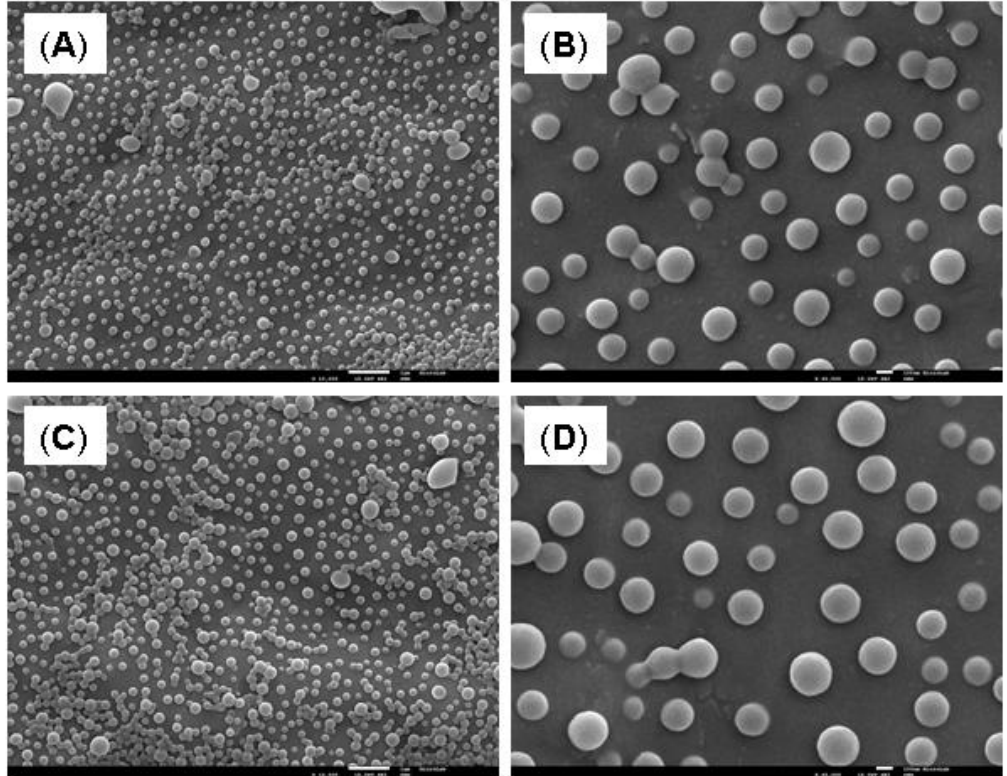
Figure 3. SEM micrographs of PLGA derivatives after oil-in-water emulsification method to form nanoparticles. ( A , B ) correspond to glucoconjugate 28 and ( C , D ) correspond to coumarin-containing PLGA derivative 29 . Left images have a magnification of 10,000 times, with the bar corresponding to 1 µ m. Right images have a magnification of 40,000 times, with the bar corresponding to 100 nm.